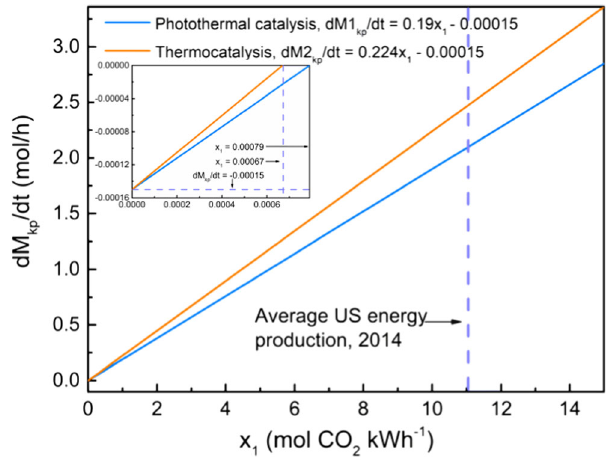
Fig.5|ReducedCO 2 footprintinphotothermalcatalysis. Thedependenceofnet CO 2 reduction rate on CO 2 emission per kWh of electricity ( x 1 ) for fl ow reactors basedon the assumptionthat H 2 isCO 2 -cost-free. The values of a , c , m , and k 2 T+b 2 were setto be 0.19, 0.005,0.03, and 0.224, respectively, according to the catalytic results and reactors used in this work. In the inset, the vertical dashed line shows the minimum x 1 which can achieve net CO 2 reduction while the horizontal dashed line represents the net CO 2 emission rates when the production of electricity is CO 2